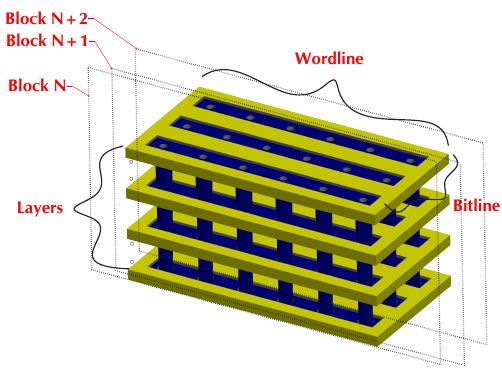
Figure 1. The layer-stacked structure of 3D flash